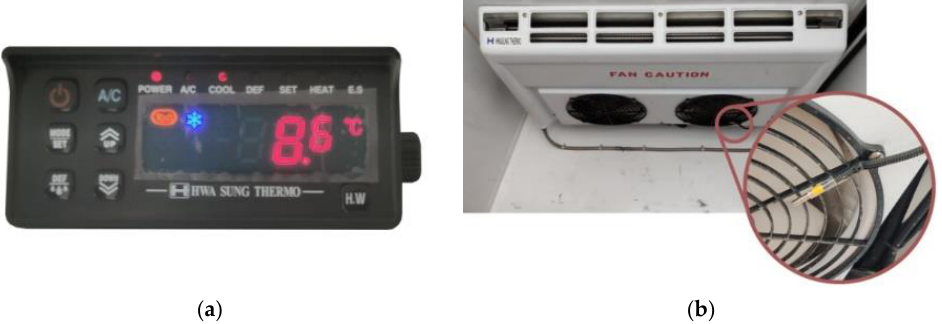
Figure 4. Controller ( a ) and heat exchanger with temperature sensor ( b ) of the trucks refrigeration